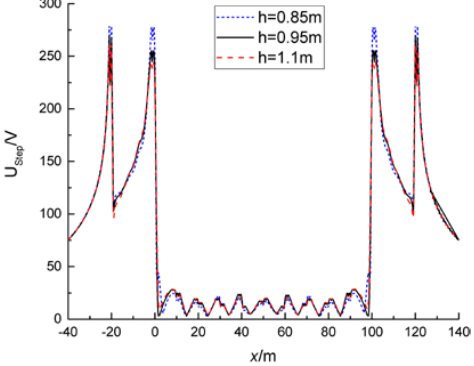
Figure 4. The change in step voltage with thickness h.